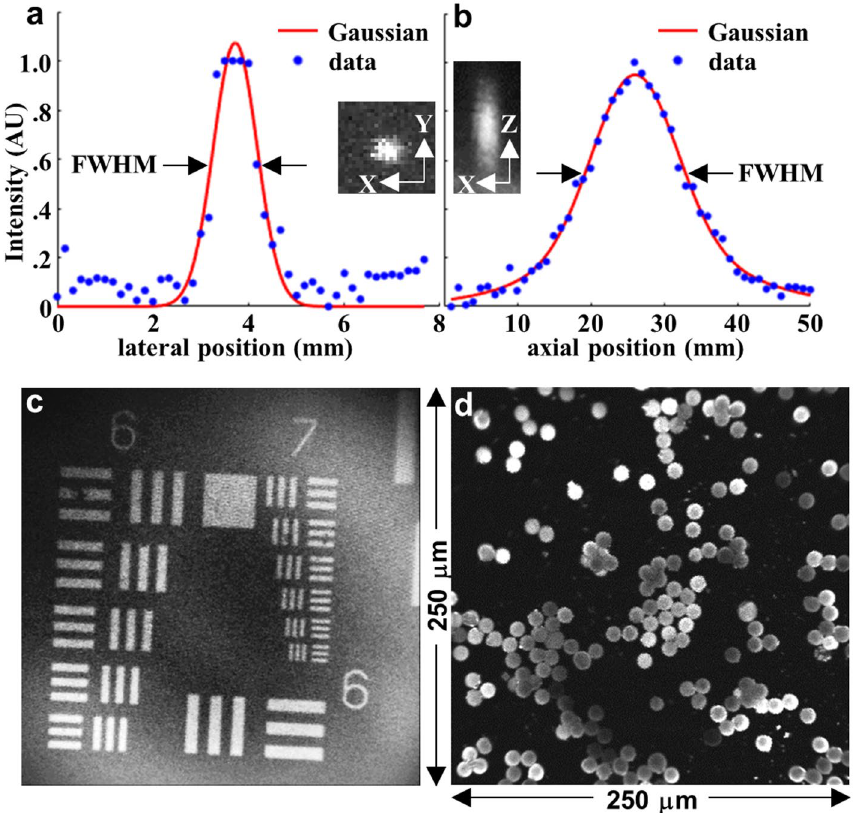
Figure 2. Image parameters. ( a) Lateral and ( b ) axial resolution of focusing optics was characterized by a point spread function (PSF) measured using 0.1 μm diameter fluorescent microspheres. A full-width-half-maximum (FWHM) of 1.1 and 13.6 μm, respectively, was measured. Inset: expanded view of single microspheres in the lateral (XY) and axial (XZ) directions are shown. ( c ) A fluorescence image collected from a standard (USAF 1951) target bars (red oval) shows that group 7–6 can be clearly resolved. ( d ) An image of dispersed 10 μm diameter fluorescent microspheres demonstrates an image FOV of 250 μm × 250 μm. PSFs in ( a, b ) were plotted using MATLAB R2019a (https:// www. mathw orks. com/). ( c, d ) Fluorescence images were collected using LabVIEW 2021 (https:// www. ni.